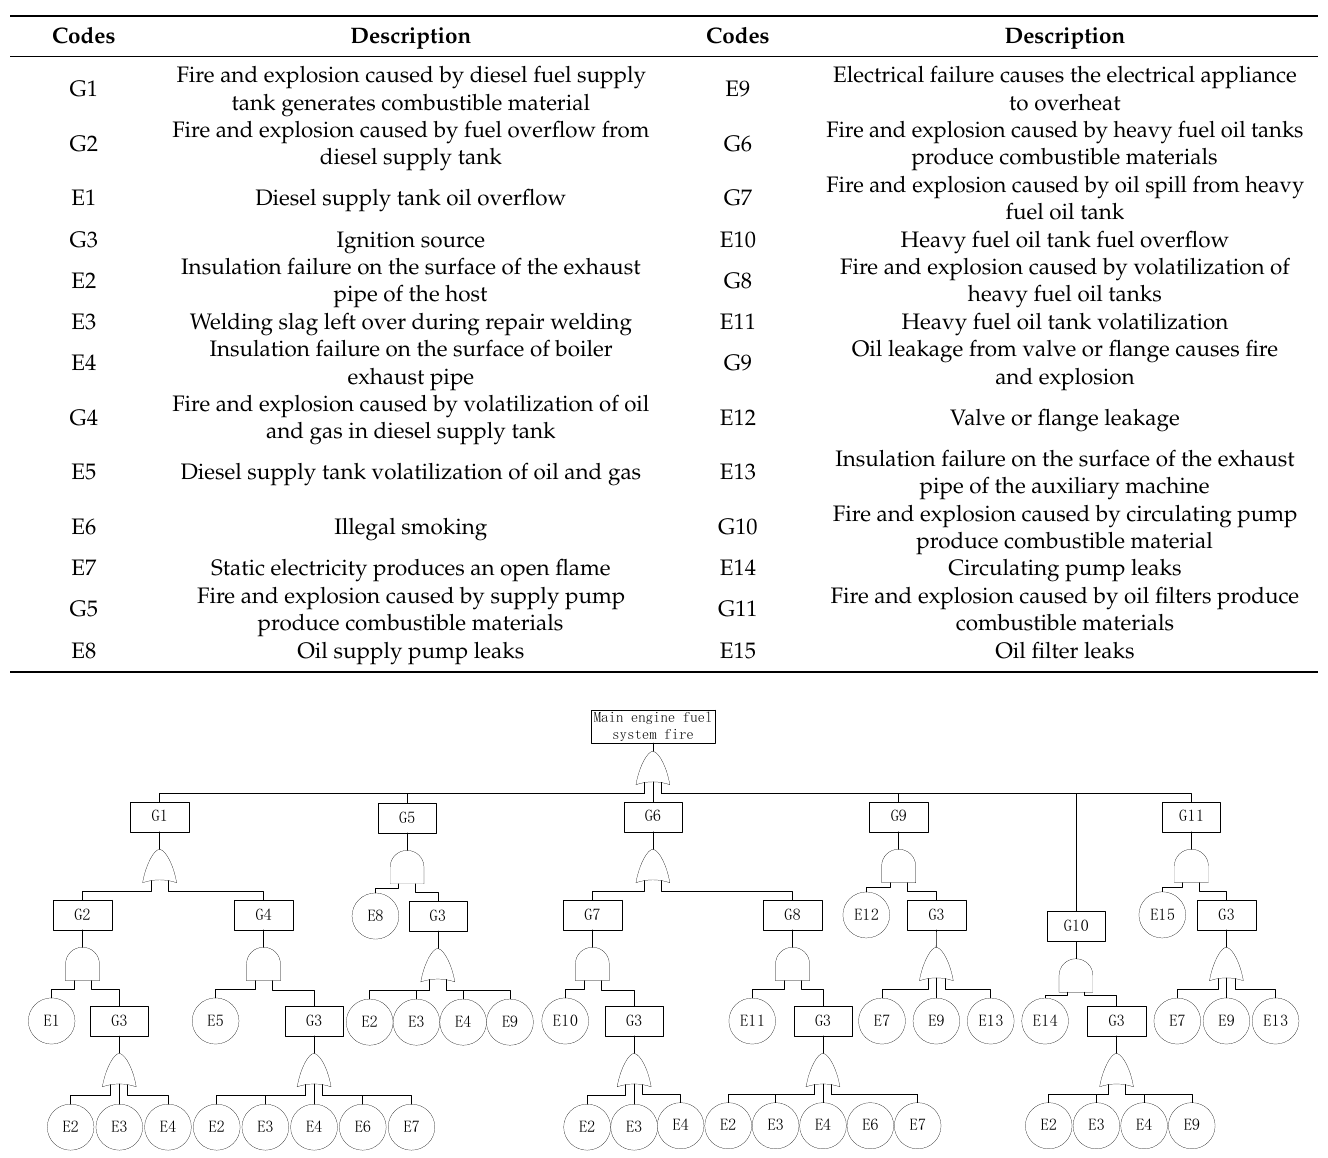
Table 7. Logic gates and principal events of a main engine fuel system fire.